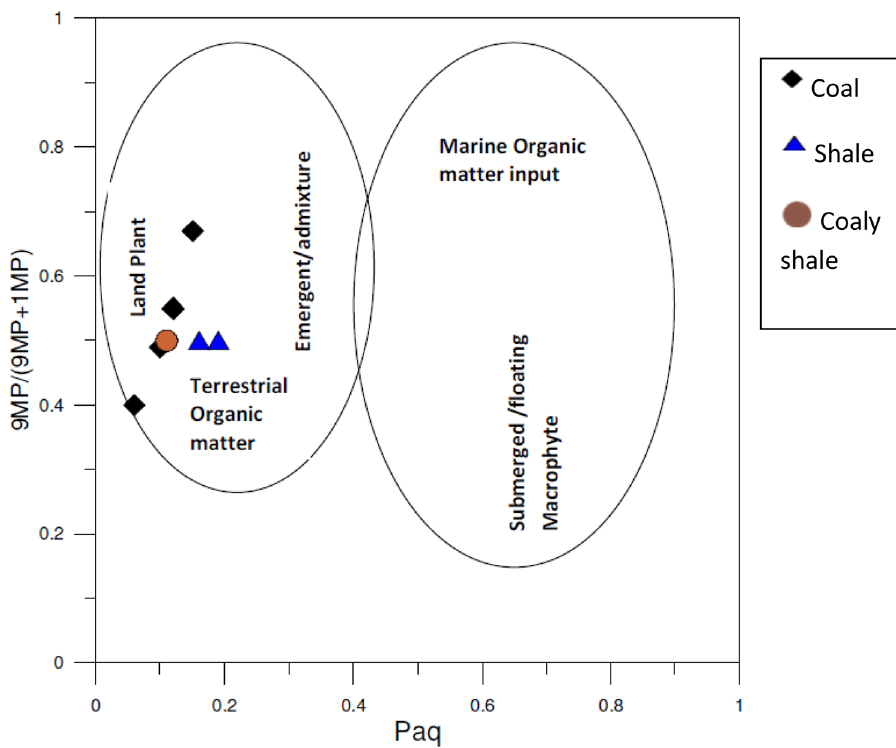
Fig. 17 Organic matter source discrimination of Maiganga samples (After Ficken et al. 2000). The source of the organic matter in the samples was prob- ably from land plant